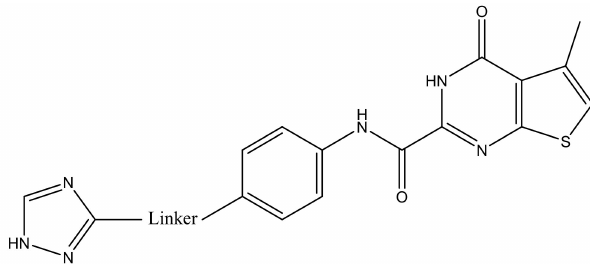
Figure 10. General structure of pyrimidine-based compounds as MMP-13 inhibitors [50].